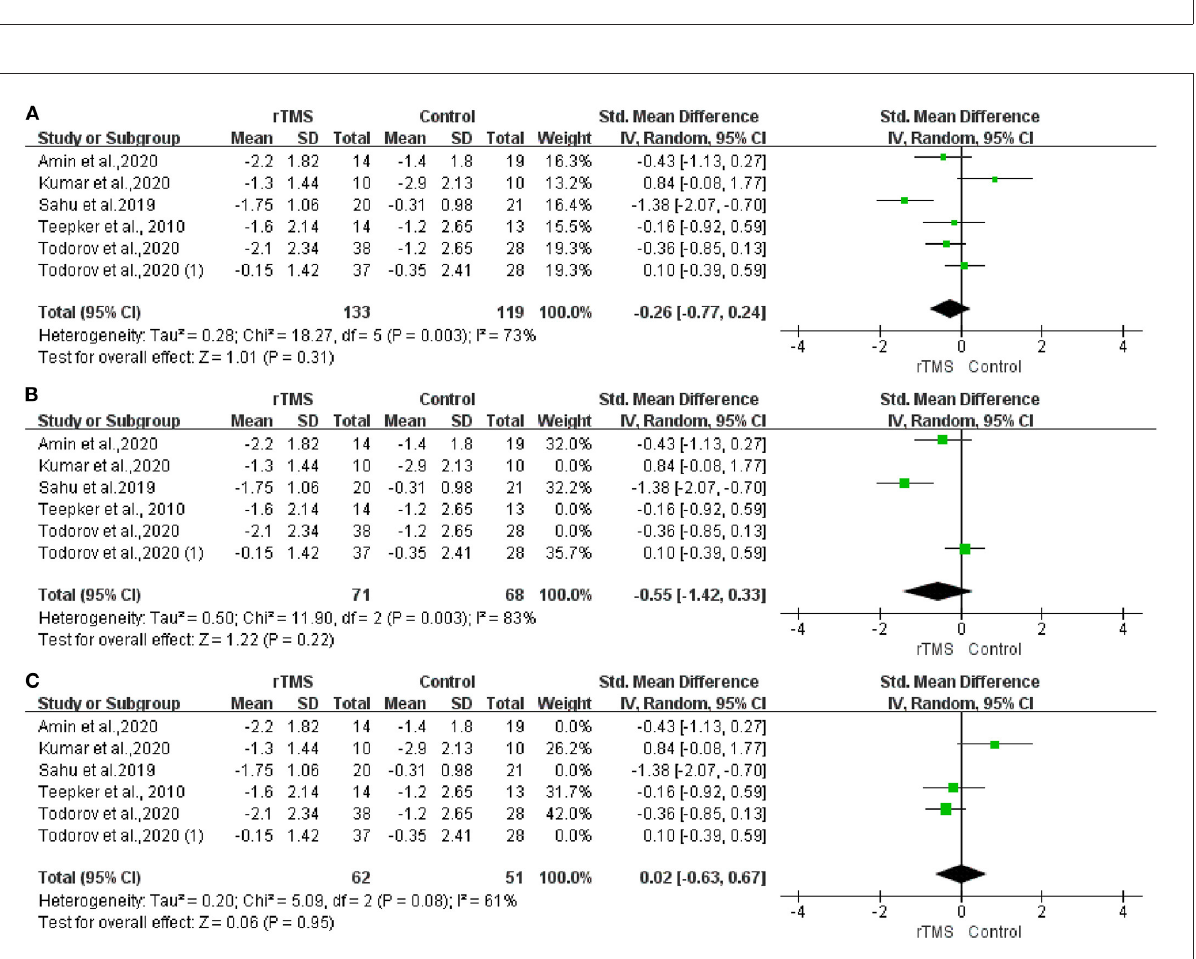
FIGURE2 Quantity of the literature.